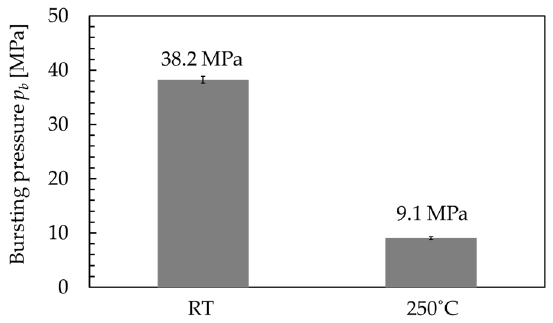
Figure 6. Bursting pressures of the small diameter ZM21 tube obtained from the bursting test result at R.T and 250 °C.